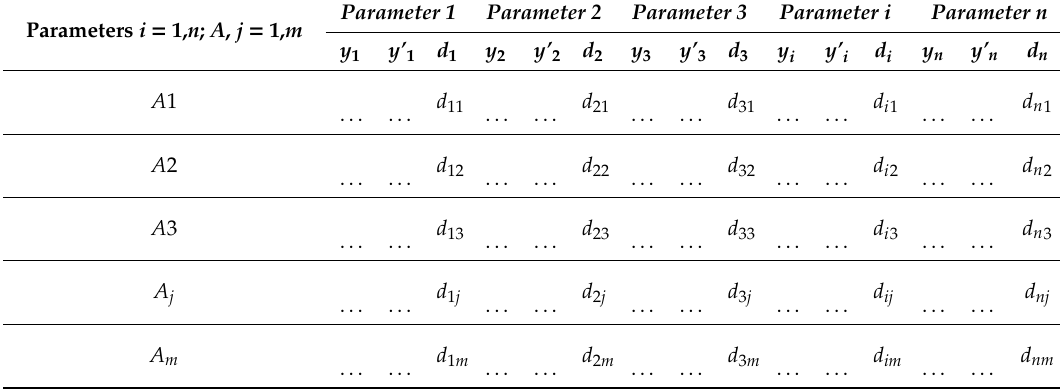
Table 5. Project assessment form according to Harrington’s